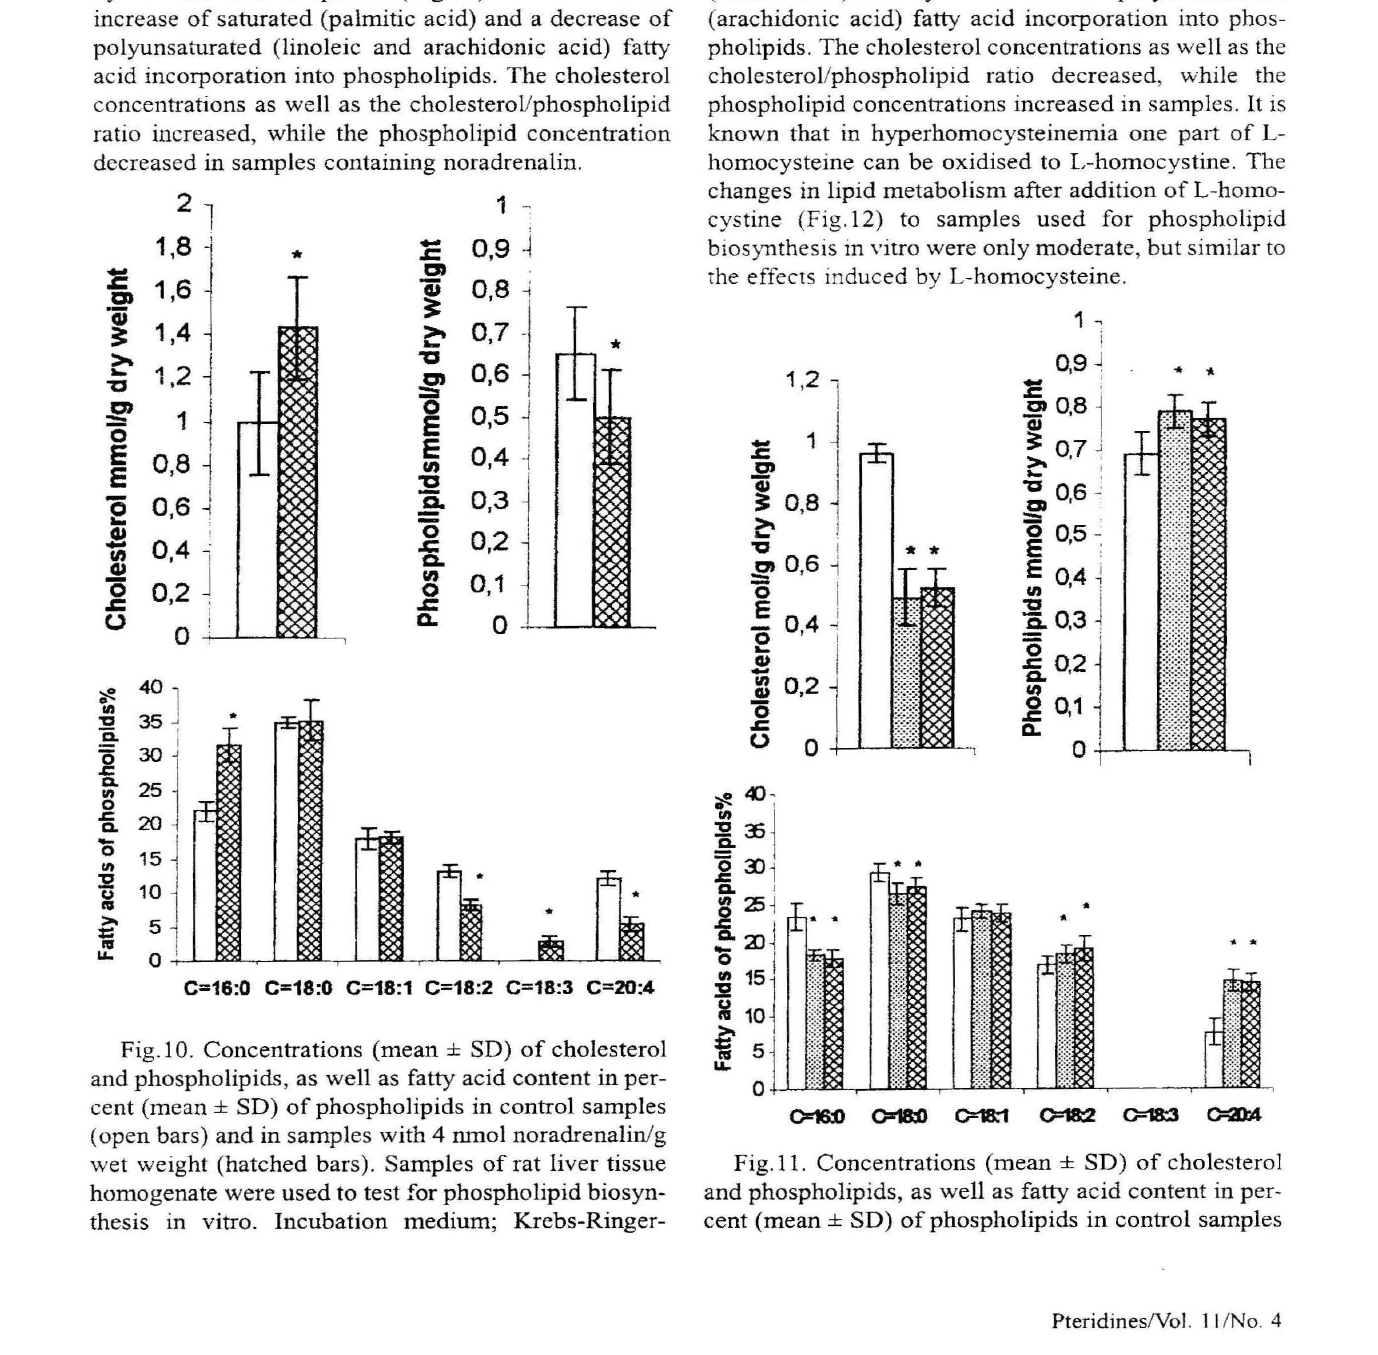
PteridinesNol. II /No.